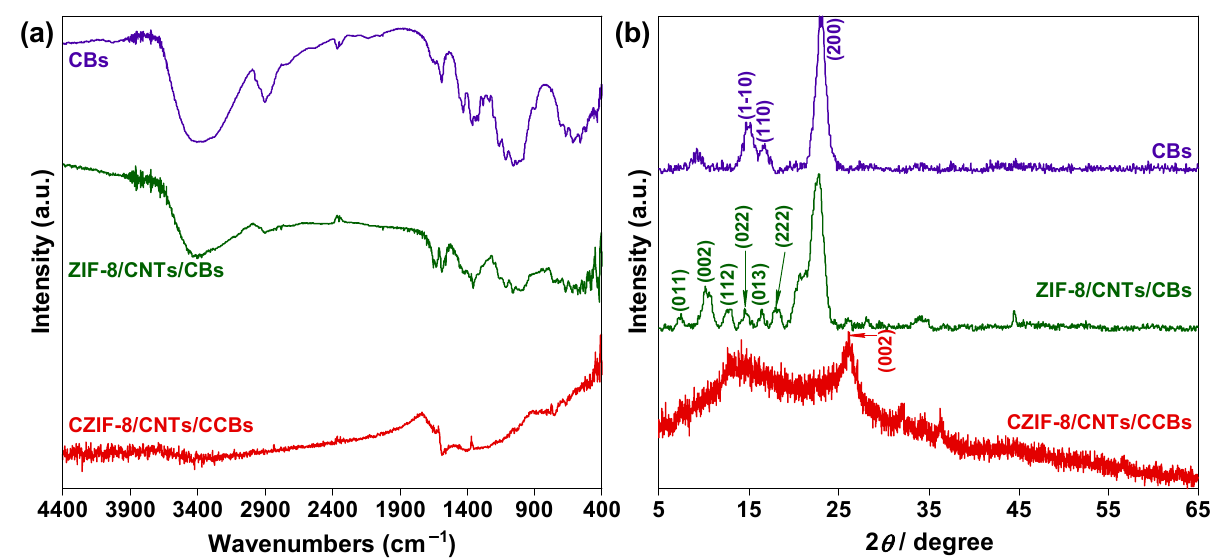
Figure 6. ( a ) FTIR spectra of CBs, ZIF-8/CNTs/CBs, and CZIF-8/CNTs/CCBs. ( b ) XRD patterns for CBs, ZIF-8/CNTs/CBs, and CZIF-8/CNTs/CCBs. Figure 7a–c shows the water contact angles of CBs, ZIF-8/CNTs/CBs, and CZIF- 8/CNTs/CCBs. CBs and ZIF-8/CNTs/CBs show good hydrophilicity, due to the existence of a hydrophilic group. After carbonization, CZIF-8/CNTs/CCBs possessed a superhy- drophobic surface with a water contact angle of 152.7 ◦ . Interestingly, the water droplet descended and contacted with the surface of CZIF-8/CNTs/CCBs. However, as the water droplet continued to rise, the water droplet and the surface of the CZIF-8/CNTs/CCBs grad- ually separated, suggesting that the sample had an ultra-low contact-angle lag (Figure 7d). As shown in Figure 8, the absorption capability of the sample was evaluated. CZIF- 8/CNTs/CCBs can quickly and completely absorb dichloromethane dyed by Oil Red O from the bottom of the water (Figure 8a). Furthermore, when CZIF-8/CNTs/CCBs contacted n-hexane dyed by Oil Red O on water, it absorbed the n-hexane in seconds (Figure 8b). These results suggest that this material has excellent oleophilic and hydropho- bic properties. The oil–water separation performance of the samples was evaluated by measuring the absorption capacities for various oils and organic liquids (Figure 9a,b). CZIF-8/CNTs/CCBs showed absorption capacities Q 1 in the range of 48 to 84 times its original weight for oil and organic liquids. The absorption capacities Q 1 of CCBs were slightly higher than those of CZIF-8/CNTs/CCBs for most of the oils and organic liquids. However, it is worth noting that the absorption capacity Q 2 of CZIF-8/CNTs/CCBs was much higher than that of CCBs. The possible reason for this result is that CCBs become lighter and smaller after carbonization of the CBs. Although the absorption capacity Q 1 of CCBs for oil and organic liquids is relatively higher, the absorption capacity Q 2 is low on account of the low actual adsorption amount. Meanwhile, ZIF-8 and CNTs were loaded into the 3D interconnected network structure of CBs, and the mass of CZIF-8/CNTs/CCBs was relatively high. Therefore, the value of the absorption capacity Q 1 was lower than that of CCBs. However, the actual adsorption amount of CZIF-8/CNTs/CCBs was much higher, due to the porous structure with large volume and the loading of CZIF-8 and CNTs, resulting in a higher absorption capacity Q 2 value. Therefore, the loading of ZIF-8 and CNTs plays a critical role in improving the adsorption performance of CZIF-8/CNTs/CCBs. As shown in Table 1, the absorption capacity of CZIF-8/CNTs/CCBs is higher than that of various previously reported sorbent materials [31,39–45]. Although the sample shows lower absorption capacity than the reported materials [46–48], the precursor material is cheaper, and the preparation method is simpler. To investigate the recyclability of the sample, the absorption–distillation test was repeated up to nine times. As displayed